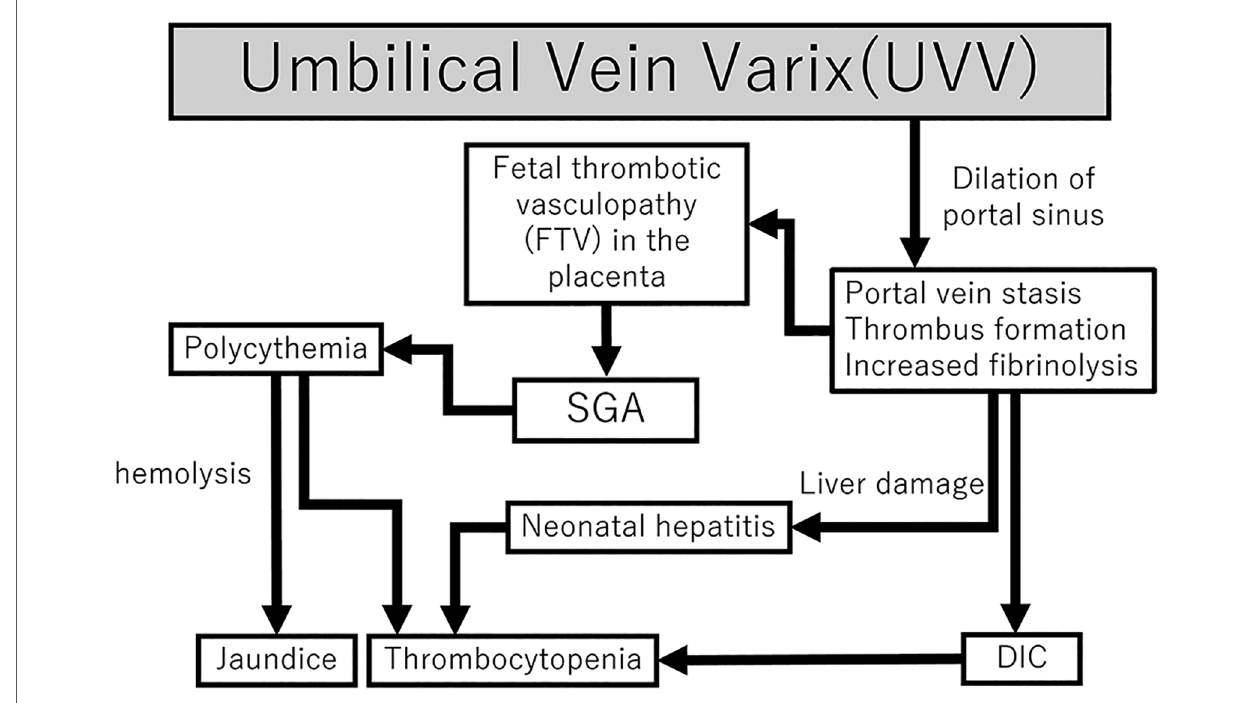
FIGURE 4 Flowchart of the mechanisms of DIC, polycythemia, and neonatal hepatitis following fetal UVV. Fetal UVV can result in DIC, SGA, and neonatal hepatitis through various mechanisms. DIC, disseminated intravascular coagulation; SGA, small for gestational age; UVV, umbilical vein